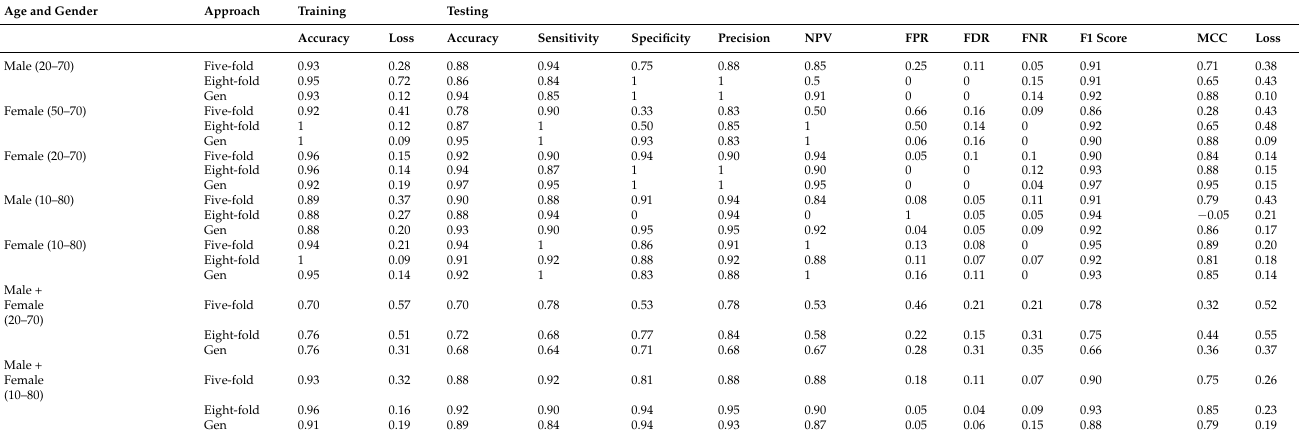
Table 5. LeNet output using age and gender (Gen = Generalization